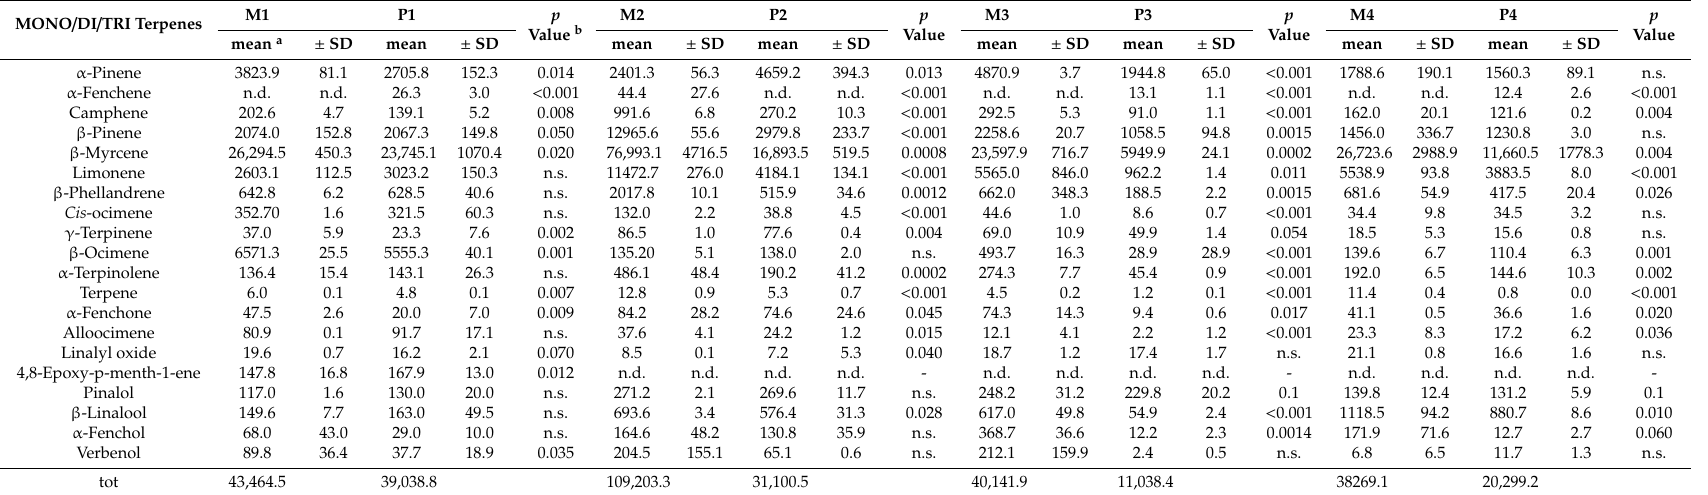
Table 1. Mono / di / triterpenes and sesquiterpenes extracted and identified by headspace solid-phase microextraction-gas chromatographic mass-spectrometry (HS-SPME-GC / MS) in mountain (M) and plains (P) inflorescences. MONO / DI / TRI